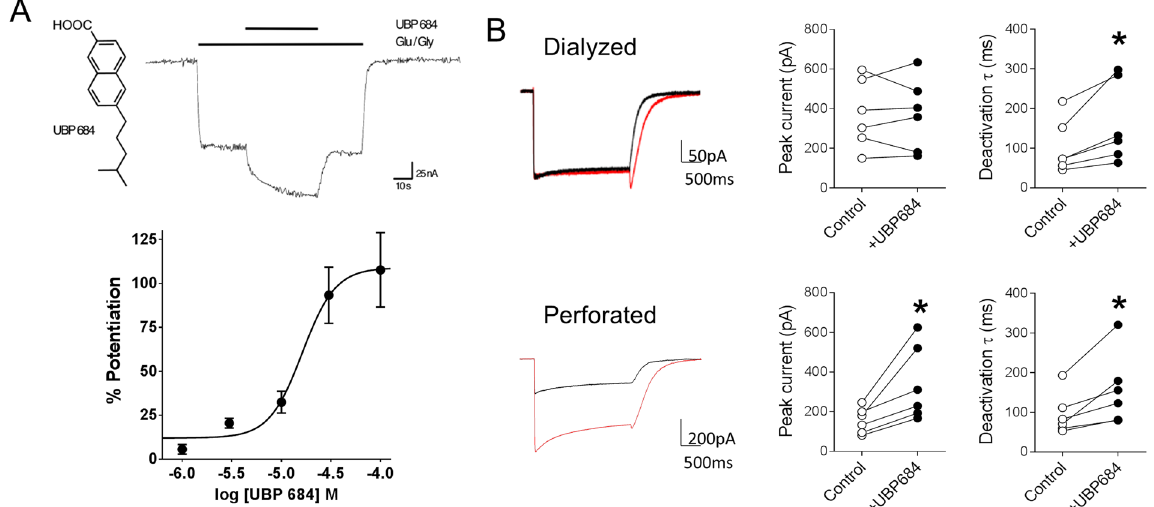
Figure 1. UBP684 potentiates GluN1/GluN2A receptor responses and slows their deactivation kinetics. ( A ) UBP684 structure and PAM activity on GluN1/GluN2A receptors expressed in Xenopus oocytes.